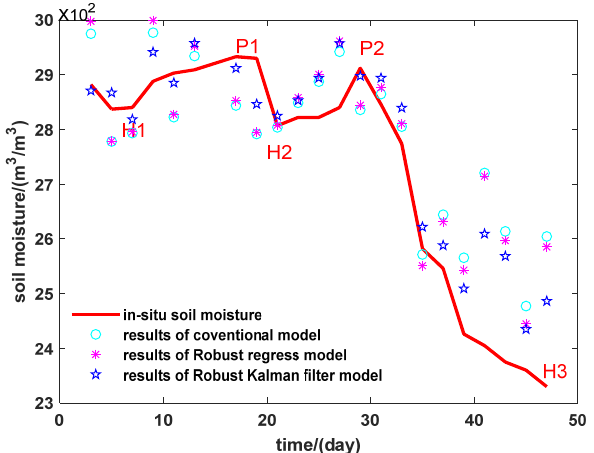
Figure 8. Estimation results of dual-band data fusion methods by using amplitude (PRN1), we highlighted for validation data the main moisture peaks (P1 day 17; P2 day 29) and holes (H1 day 6; H2 day 20; and H3 day 47). We can note that the difference between H1 and P1 is less than 1*10-2 m 3 /m 3 and between H2 and P2 it is ~1*10 -2 m 3 /m 3 which is low and will allow us to test the precision of the inversions and to show the capacity of this technique to differentiate between very weak soil moisture fluctuations.